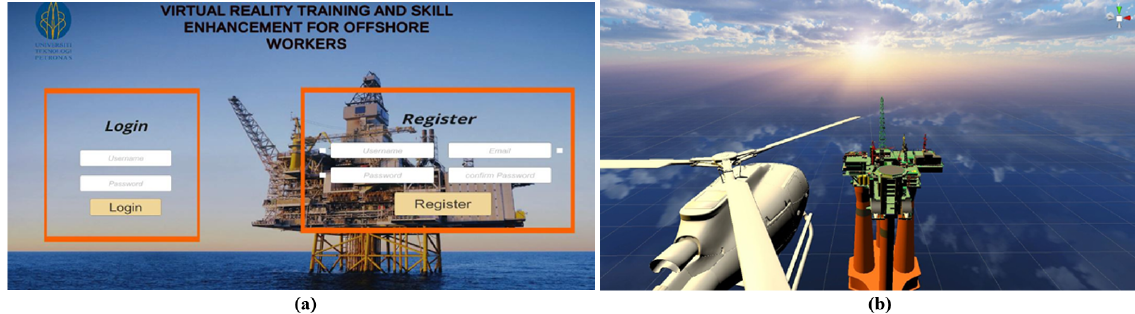
Figure 1. ( a ) Startup interface of the VR-training module and ( b ) the initial scene of arriving at offshore platform.